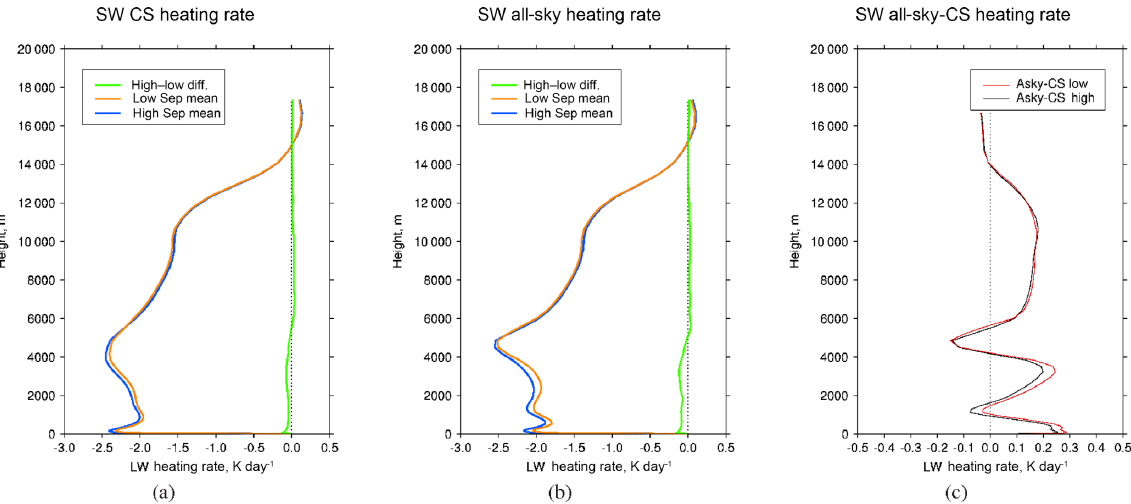
Figure 13. September mean LW heating rates (averaged over the BB box 5–25 ◦ S, 40–70 ◦ W) for high and low emissions for (a) clear sky, (b) all sky and (c) all-sky–clear-sky